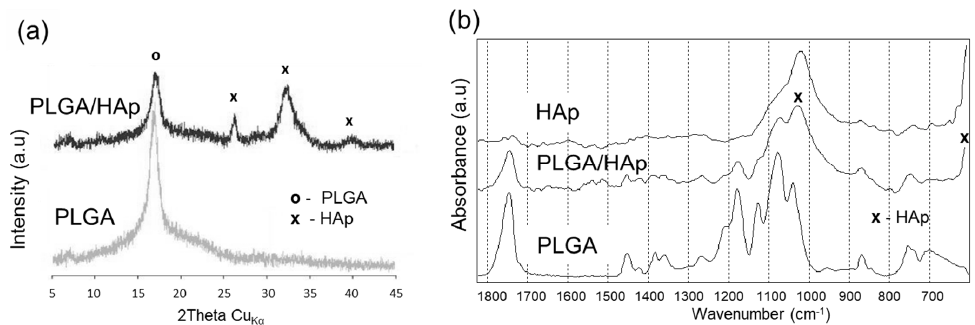
Figure 2. X-ray di ff ractometry (XRD) patterns ( a ) and Fourier transform infrared (FTIR) spectra Figure 2. X-ray diffractometry (XRD) patterns ( a ) and Fourier transform infrared (FTIR) spectra ( b ) ( b ) of PLGA and PLGA / HAp sca ff olds. Pics ( a ) and bands ( b ) marked by “x” are characteristic of PLGA and PLGA/HAp scaffolds. Pics ( a ) and bands ( b ) marked by “x” are characteristic for for hydroxyapatite. hydroxyapatite.